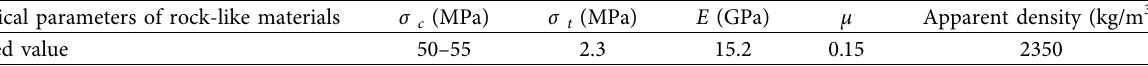
Table 1: Mechanical parameters of the rock-like material.